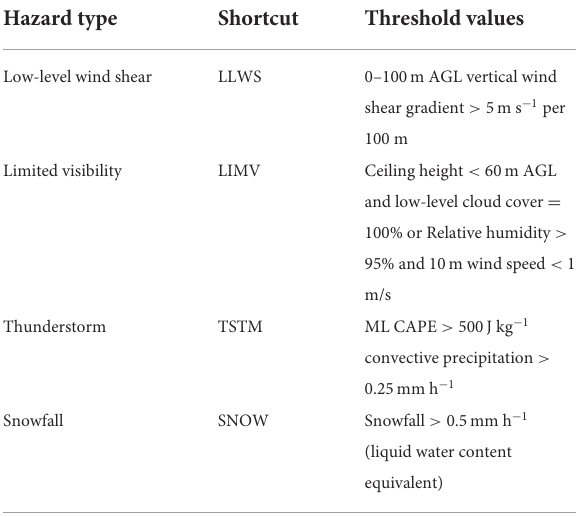
TABLE 1 Threshold values for proxies defining particular types of hazardous